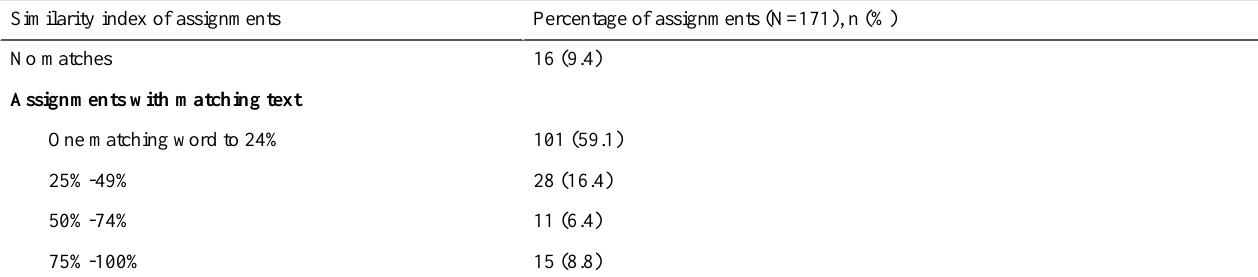
Table 5. The evaluation of plagiarism in the learner summary assignments in Run 1 of the course.